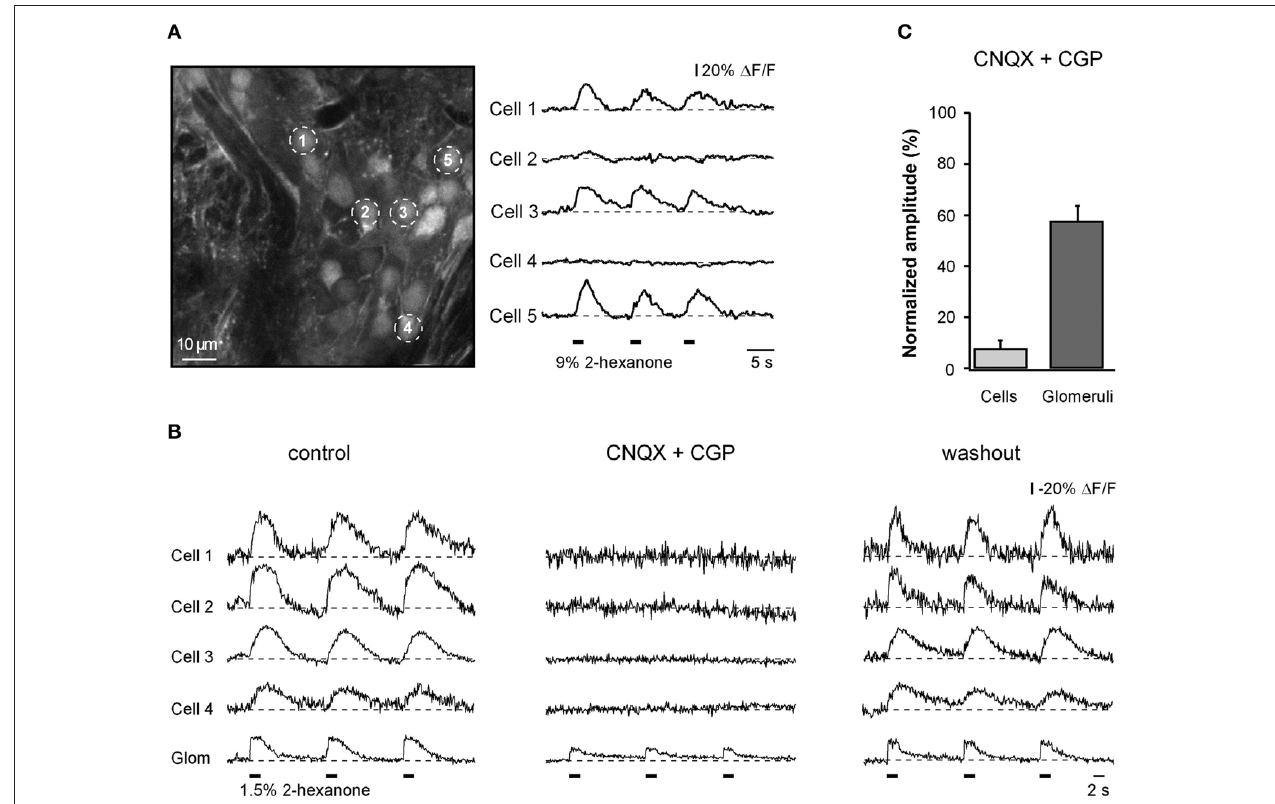
FIGURE 2 | Cellular and glomerular odor-evoked calcium signals. (A) (cid:2) F/F traces (right) recorded from juxtaglomerular neurons marked with respective numbers in the left panel. In this and subsequent figures the timing of odorant presentations is indicated as thick black bars below the traces. Note that only a fraction of cells (1, 3, and 5) showed odor-evoked Ca 2 + responses. (B) (cid:2) F/F traces recorded from four different cells and the corresponding glomerulus in